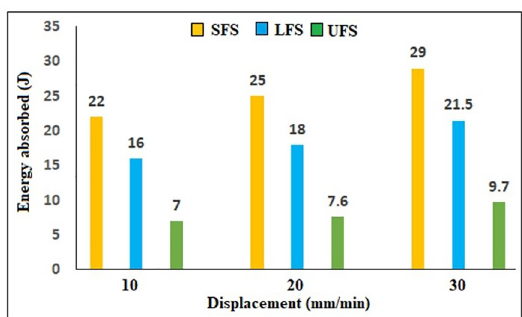
Figure 3. Energy absorbing behavior of composite